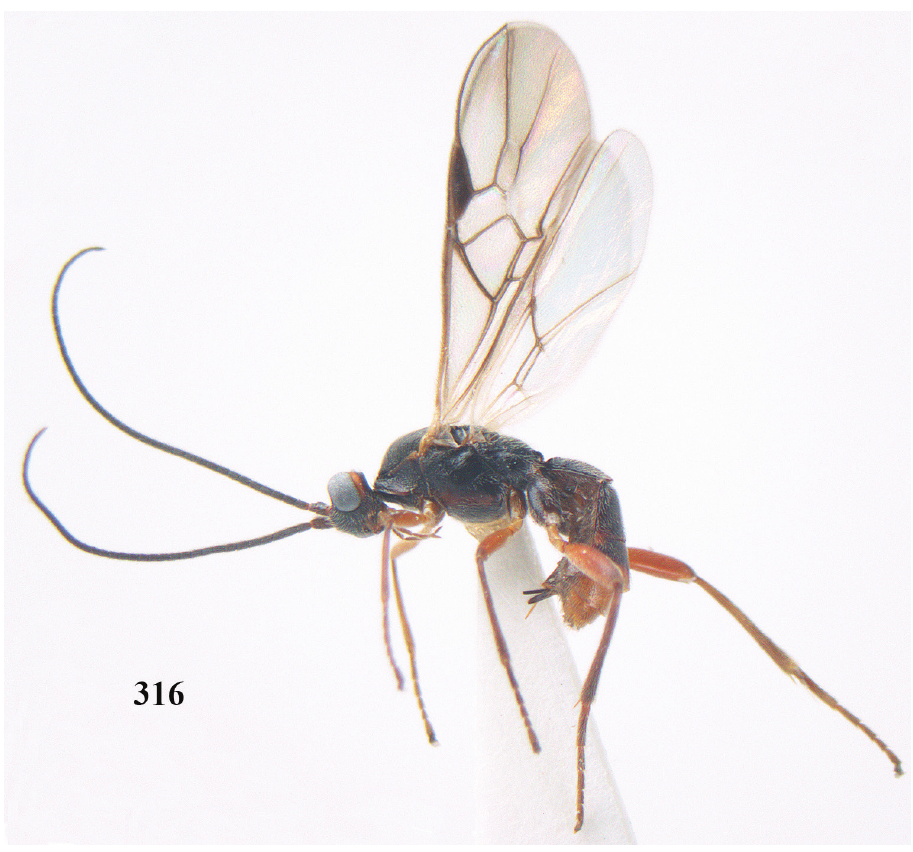
Figure 316. Aleiodes ryrholmi sp. n., ♀ , holotype, habitus lateral. 0.35 × minimum width of face (Fig. 323) and face mainly granulate, dorsally superfi- cially rugulose; length of eye 4.5 × temple in dorsal view and temple directly narrowed behind eye; occiput behind stemmaticum mainly granulate-coriaceous and occipital carina widely interrupted medio-dorsally and nearly complete ventrally (Fig. 325); clypeus above lower level of eyes (Fig. 323); length of malar space 0.35 × height of eye in lateral view; eyes protuberant (Figs